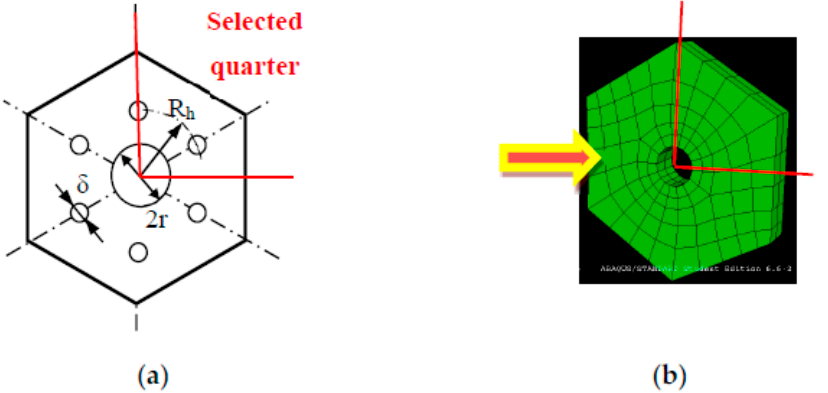
Figure 11. Selection of a quarter of a (hexagonal) PM ( a ) for an FEA ( b ), highlighting the three constructive (mounting) parameters r , δ , and R h .